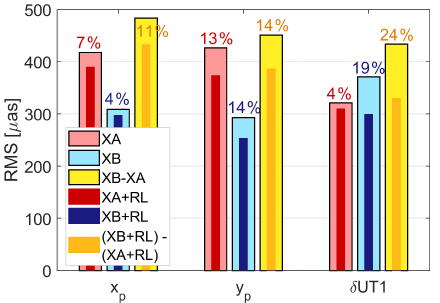
Figure 3. Mean (a) and RMS (b) of detrended ERP estimates and differences from the original CONT17 networks.